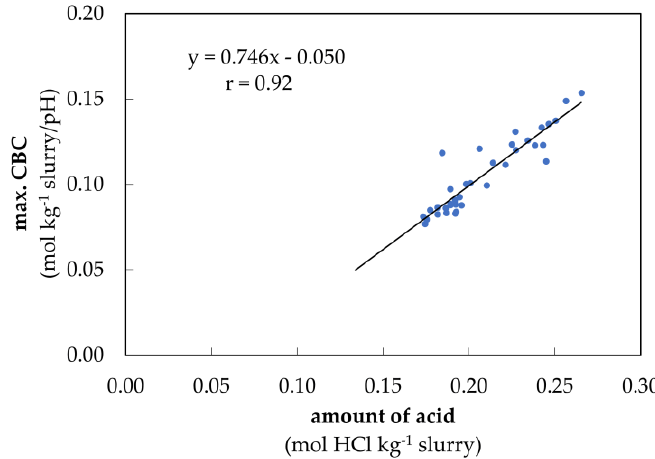
Figure A1. Maximum CBC during acidification in the VFA buffer depending on the amount of acid from pH value 5.5 to 3.0 of the dairy cow slurry (n = 36).